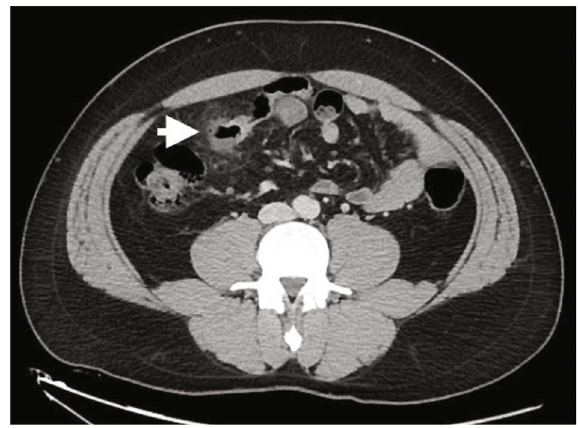
Figure 3: Abdominal computed tomography showing a blind- ending gas- fi lled structure with surrounding fat stranding and in continuity with small bowel from the antimesenteric border of the ileum (arrow).